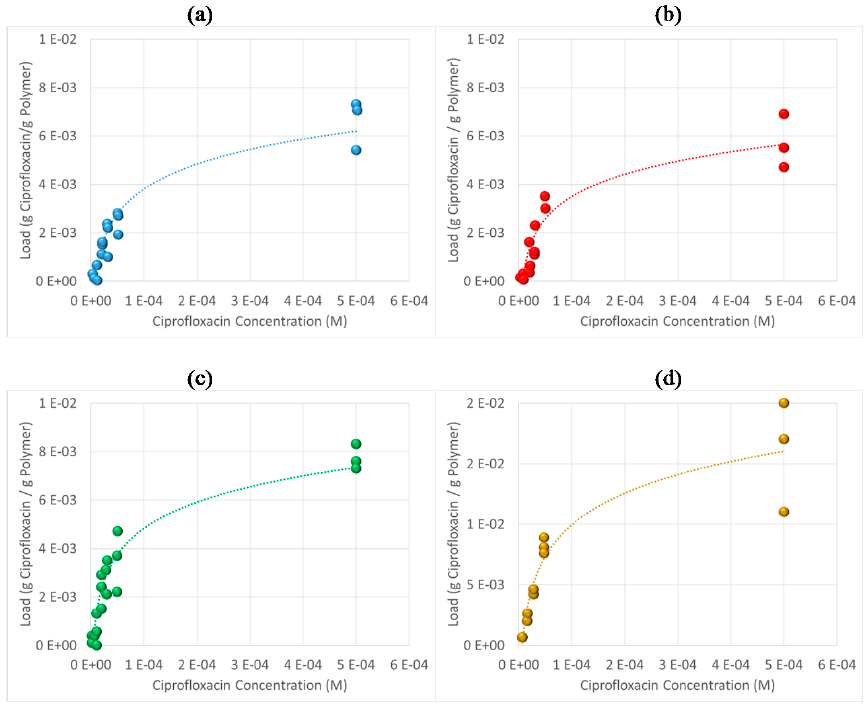
Figure 14. Adsorption isotherm charts for hydrogels synthetized by FRP. Samples: ( a ) G311; ( b ) G312; ( c ) G313; and ( d ) G314.